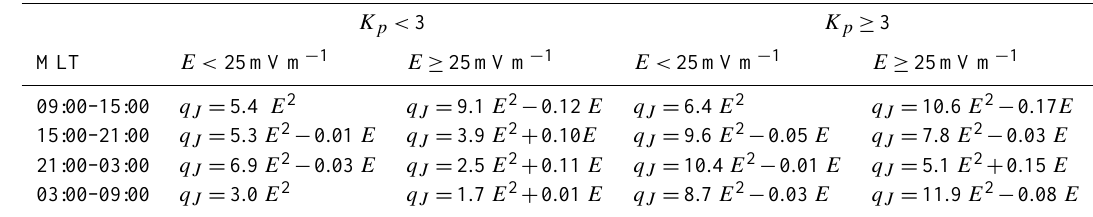
Table 1. Joule heating rate q j (in units of Wm − 2 ) as a function of total electric field E (in units of Vm − 1